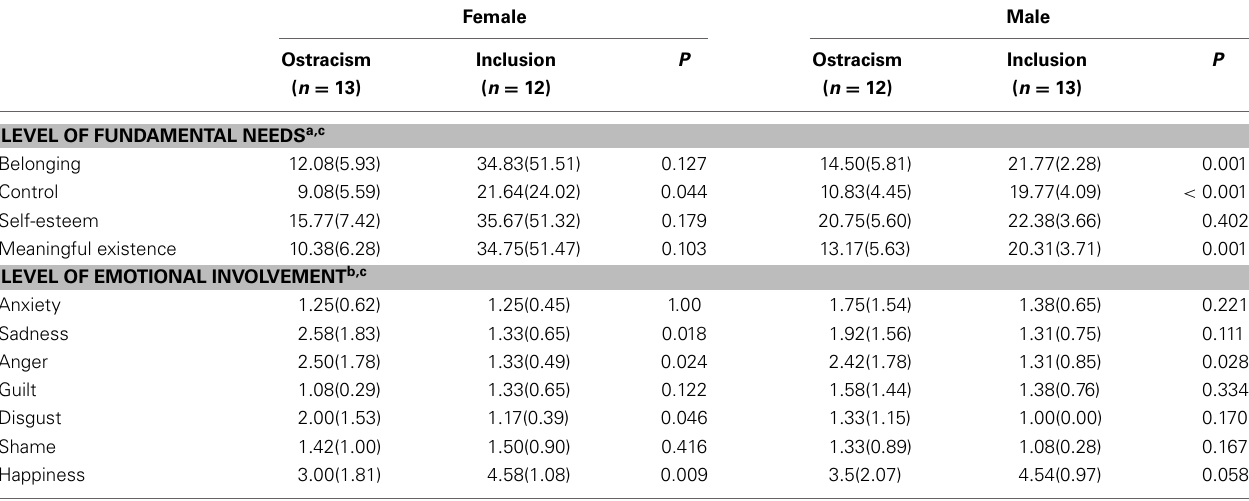
Table 3 | Means and standard deviations (in parentheses) of fundamental needs and levels of emotional involvement separated by